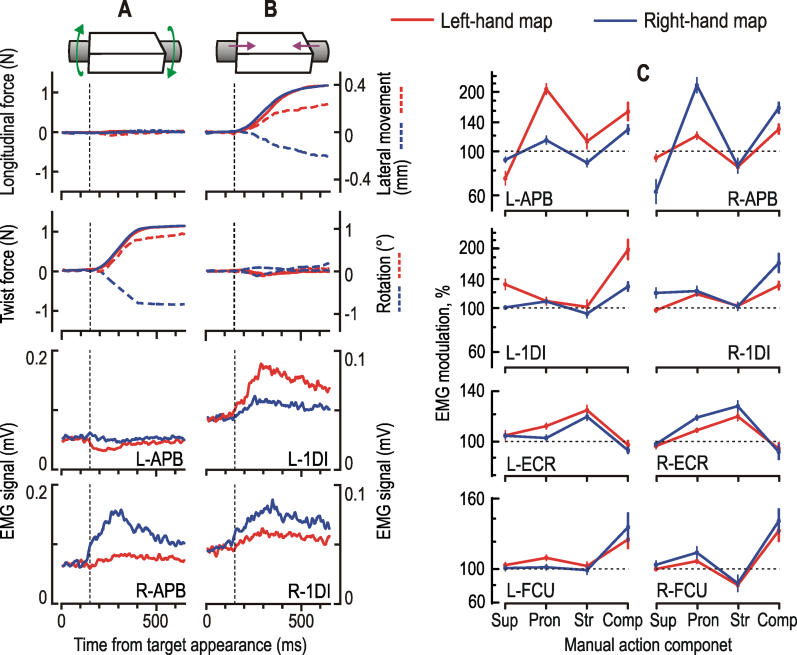
Effects of Mapping Rule on Use of Intrinsic (APB, 1DI) and Extrinsic (ECR, FCU) Hand Muscles(A) Solid curves and left abscissas show as a function of time longitudinal force, twist force and EMG signals from the left (L) and right (R) APB during vertical cursor movement generated by supination actions by the left hand together with pronation actions by the right (see top panel). Dashed curves show related tool movements (ordinate in [B]). Note the reversal in tool rotation with map changes (red and blue curves).(B) EMGs from the 1DI muscles during horizontal cursor movements generated by compression forces between the handles (ordinate in [A]). Note the reversal of lateral displacement associated with map changes.(A and B) Data averaged across all participants referenced to the appearance of the peripheral target. Force and object movement signals referenced to direction of supination and longitudinal compression by the left hand.(C) Relative change in EMG amplitude for all eight muscles during the center-out cursor movements plotted against manual action (
Sup, supination torque,
Pron, pronation torque;
Str, stretch force and
Comp, compression force). Participant means (± 1SEM;
n = 8) computed on a logarithmic scale. Irrespective of its location, the mean absolute value of the forces applied tangentially to the handles when hitting a peripheral target was 1.25 N.